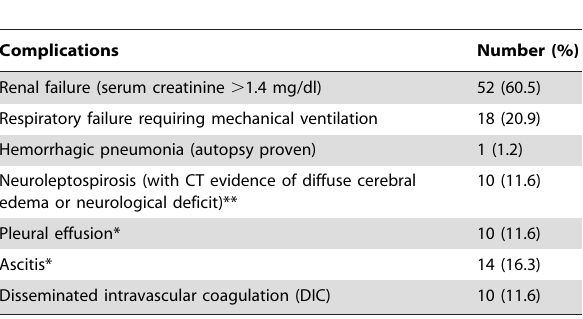
Table 6. Complications of leptospirosis cases while in hospital.